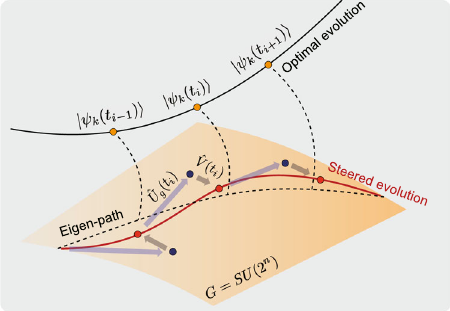
Fig. 2 Quantum control ̂ V ð t Þ steers the free evolution ̂ U g ð t Þ to evolute along the “ eigen-path" approximately, where ψ k denotes the k th eigenstate of ∂ g ̂ Hsen ð t Þ . G denotes a Lie group and the manifolds U , V ∈ G . The blue points are the propagator without control and the red points, on the contrary, is the DRL manipulated